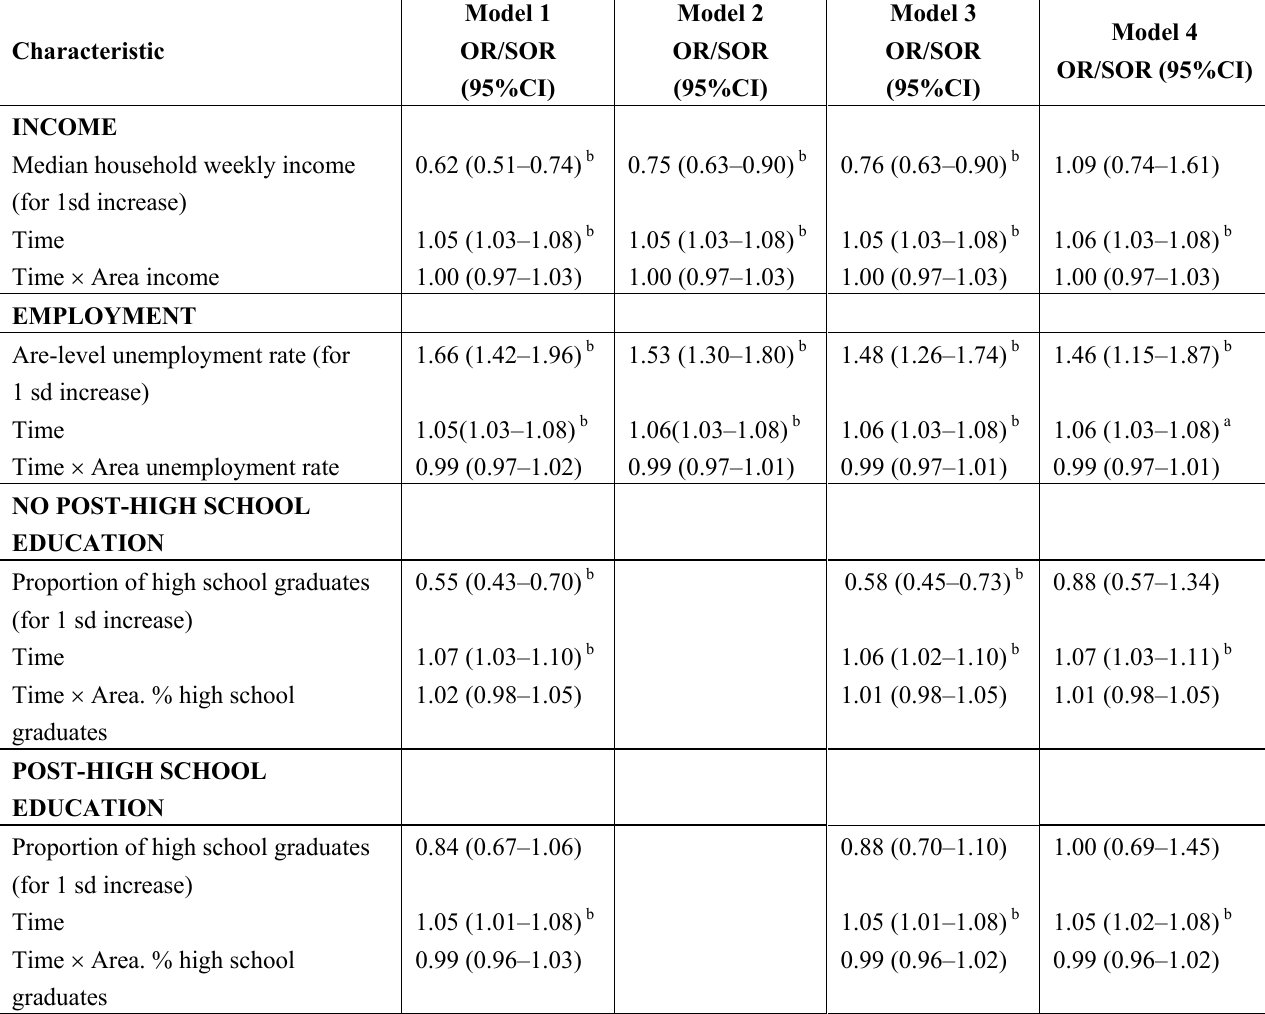
Table 3. Associations between area-level SEP and baseline prevalence and trajectory of